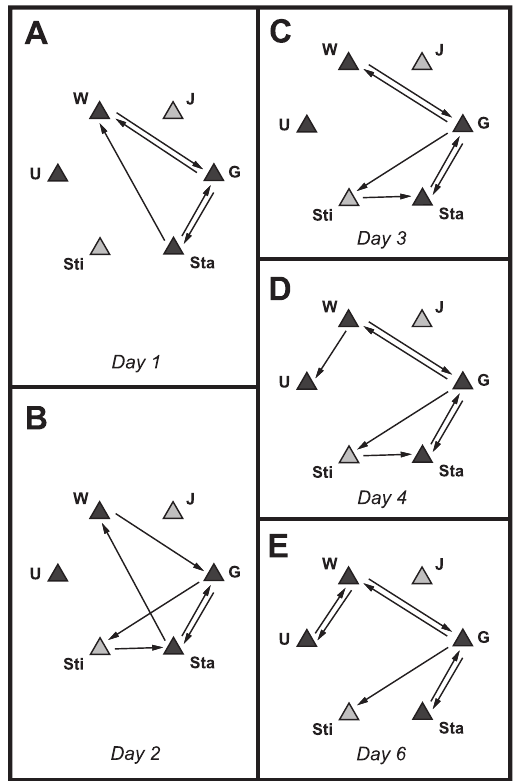
Figure 14. Statistically significant behavioral transitions for each of the age cohorts in the single male experiments. Simplified kinematic diagrams illustrating behavioral transitions that occurred more often than predicted by chance on days of age 1 (A), 2 (B), 3 (C), 4 (D), and 6 (E). Arrows indicate the direction of the transition. Abbreviations refer to the behaviors (see Table